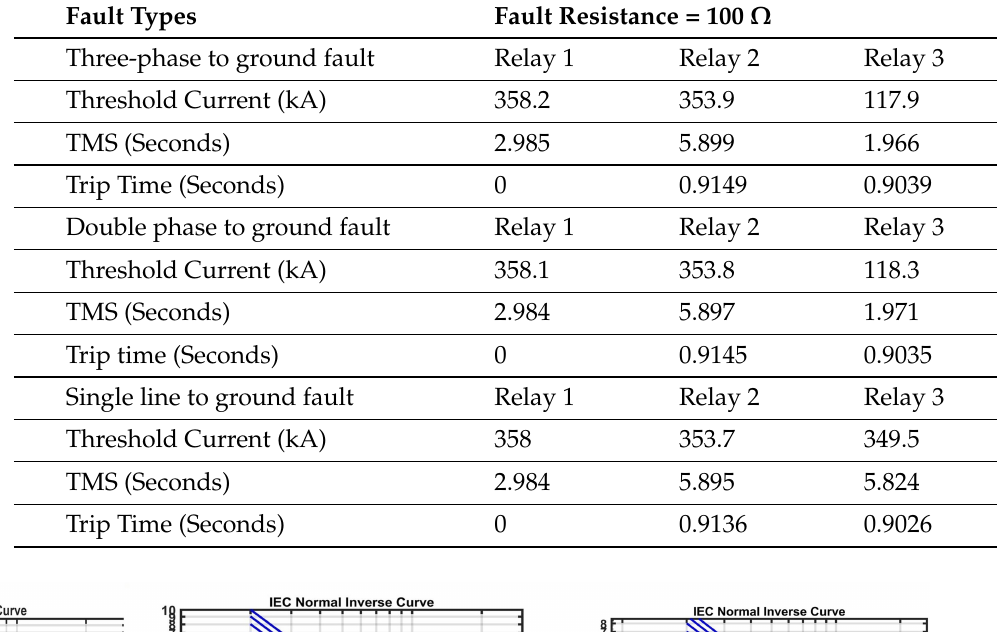
Table 6. Threshold current at fault resistance of 100 Ω .